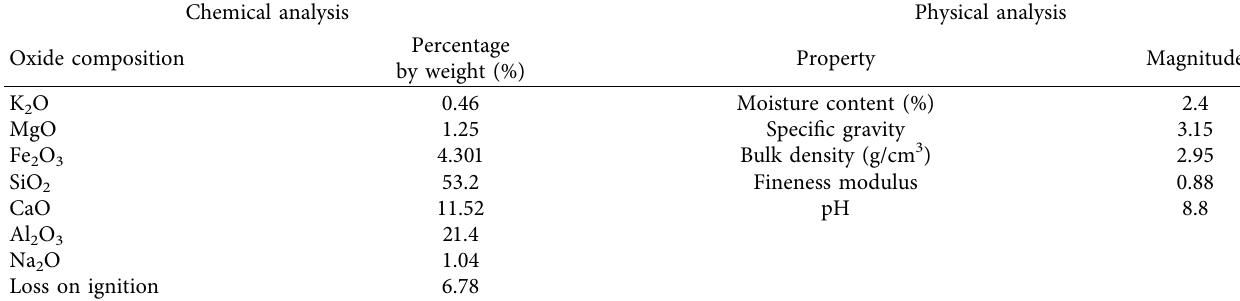
Figure 1: (a) Research process fowchart. (b) Natural rubber latex. Table 1: Oxide composition and physical properties of cement used.